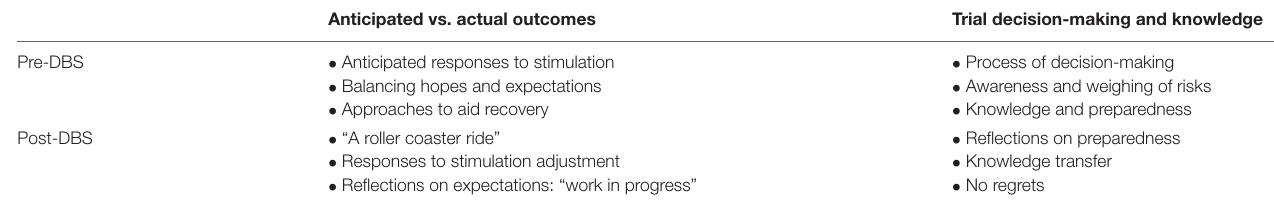
TABLE 2 | Thematic analysis